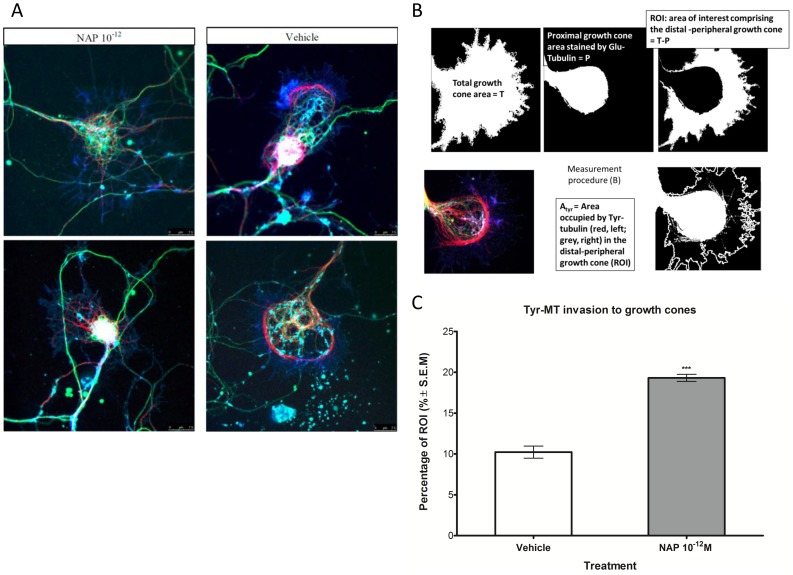
NAP effect on Tyr-MT invasion to growth cones.(a) Glu-MTs (green) do not invade the peripheral domain of the growth cone. NAP clearly affected Tyr-MT (red) invasion to the peripheral domain of the growth cone in terms of number and length of this invasions. Actin is labeled in blue (Coumarin Phalloidin) and cell membranes are stained in cyan (Dil). Bars: 7.5 µm. (b) Analysis of MT invasion - the total area in the image covered by actin and membrane dyed using DiI determined the growth cone area (T). From this determined area we subtracted the area occupied by Glu-MT (proximal growth cone area, P) which gave us our region of interest (ROI), as illustrated, with a representative picture and termed Atyr (area including Tyr-MT). (c). The percentage of the ROI penetrated by Tyr-MT was obtained, calculated and graphed, right hand side, (t-test, p<0.0001, n = 22/treatment group).